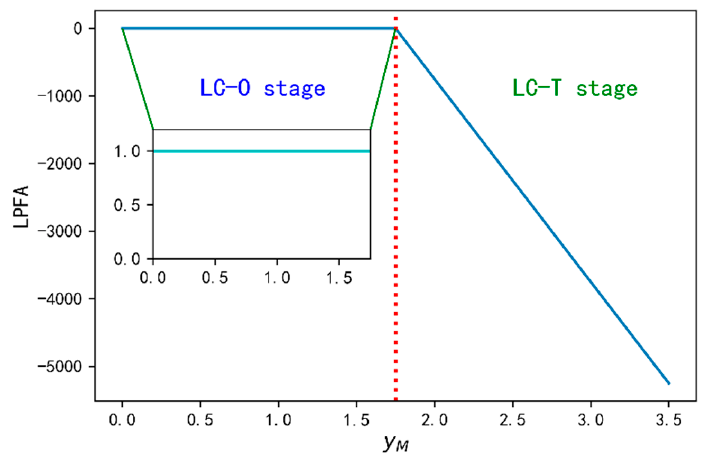
Figure 4. The trajectory curve of linear piecewise function LPFA . In order to explain the physical meaning of introducing a linear piecewise function, i.e., LPFA ( ∗ ) , in the longitudinal safety distance constraint, the longitudinal distance constraint between vehicles C and M, presented in (13) is illustrated as an example. By introducing LPFA ( ∗ ) , the right side of inequality (13), i.e., S safe